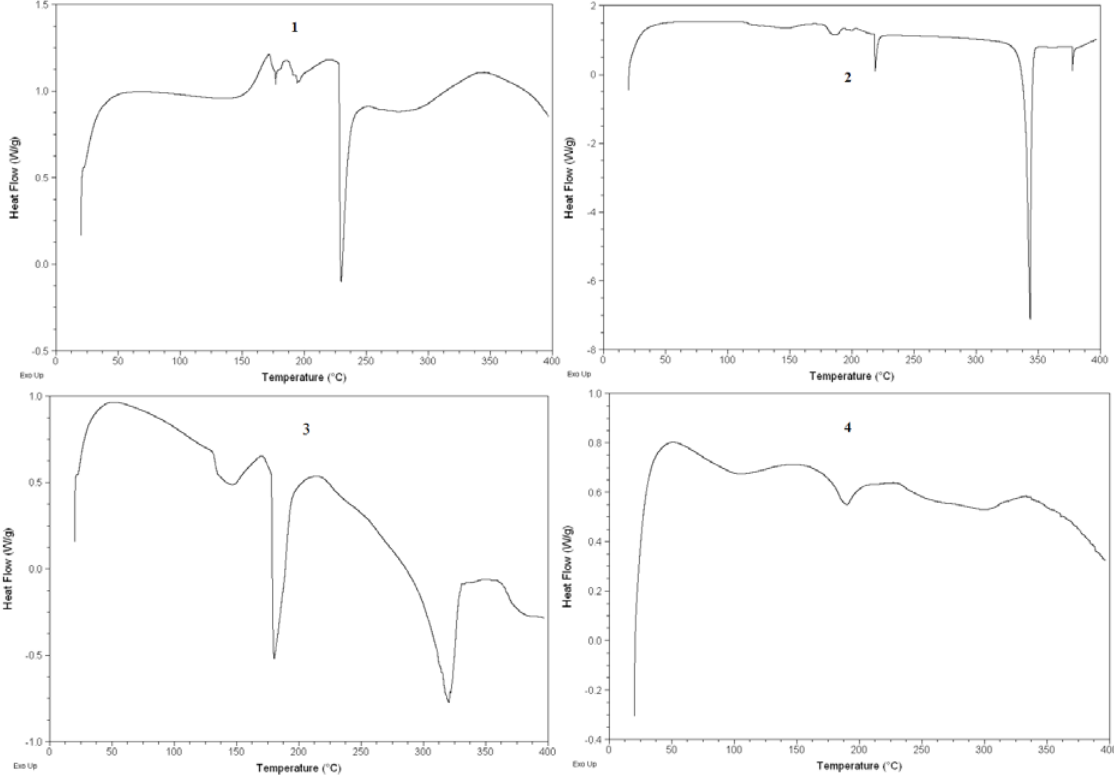
Figure 5. DSC curves of luteolin (1), phospholipid (2), physical mixture of luteolin and phospholipid (3), luteolin-phospholipid complex (4).